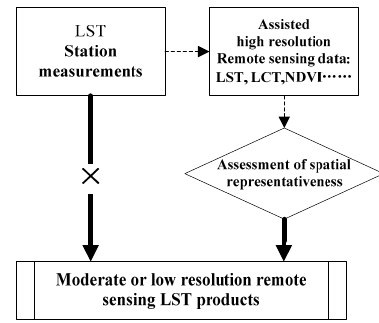
Figure 1. New scheme for land surface temperature (LST) validation based on the assessment of local spatial representativeness (site level). In the scheme, LCT is the abbreviation of land-cover type, and NDVI is the abbreviation of normalized difference vegetation index.